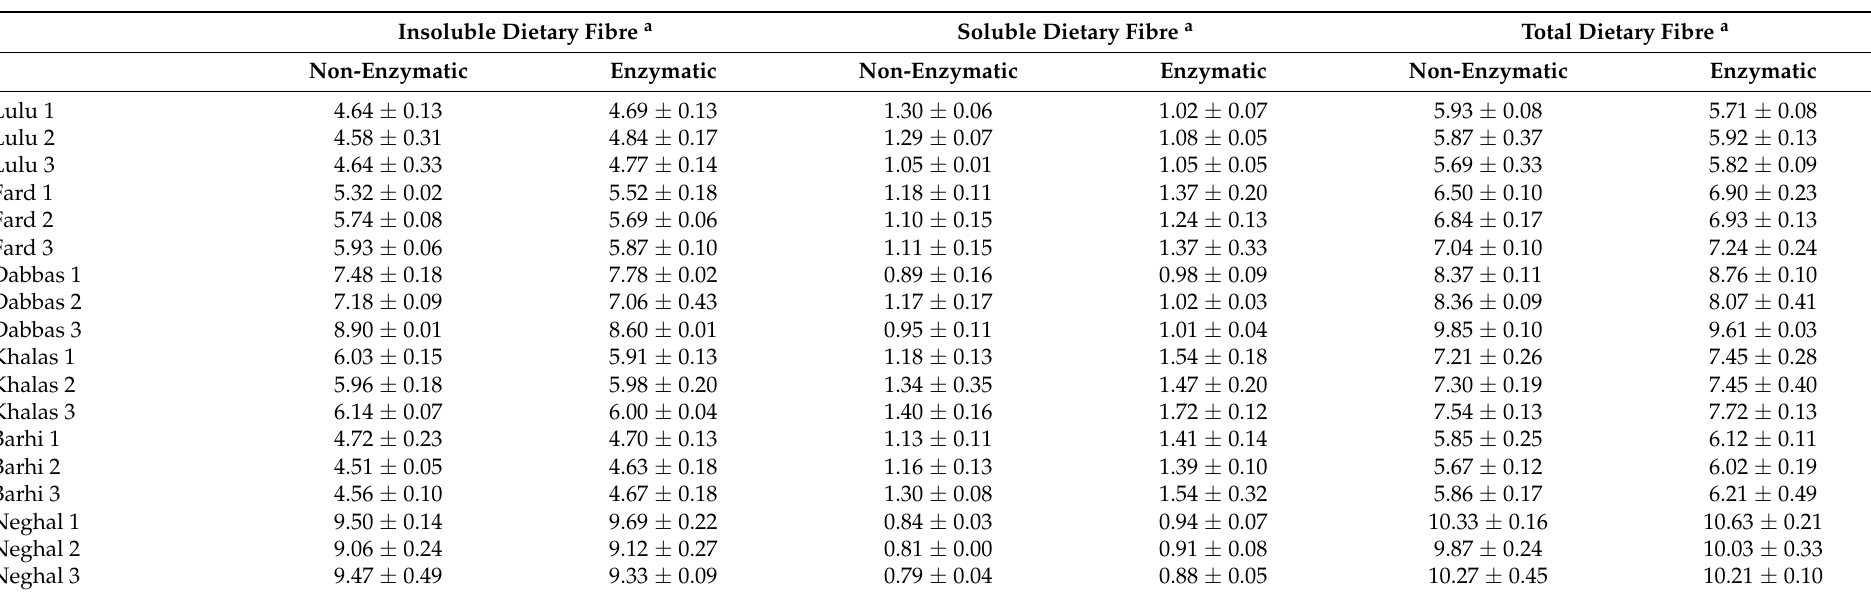
Table 1. Analysis of dietary fibre in different varieties of date fruits using enzymatic gravimetric method with and without enzymatic digestion. Insoluble Dietary Fibre a Soluble Dietary Fibre a Total Dietary Fibre a Non-Enzymatic Enzymatic Non-Enzymatic Enzymatic Non-Enzymatic